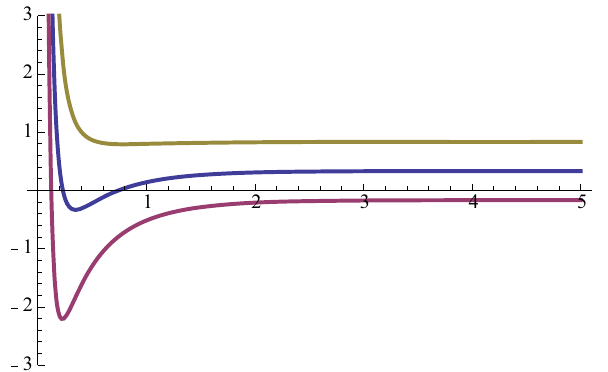
ρ(χ)/ 3 for H 3 . (i) RN black- 0